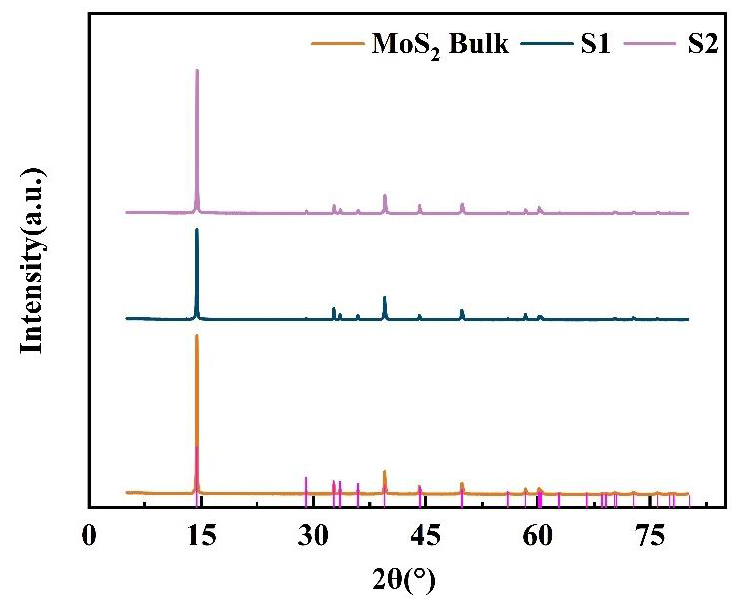
Figure 1. XRD patterns of the bulk MoS 2 : S1 and S2.